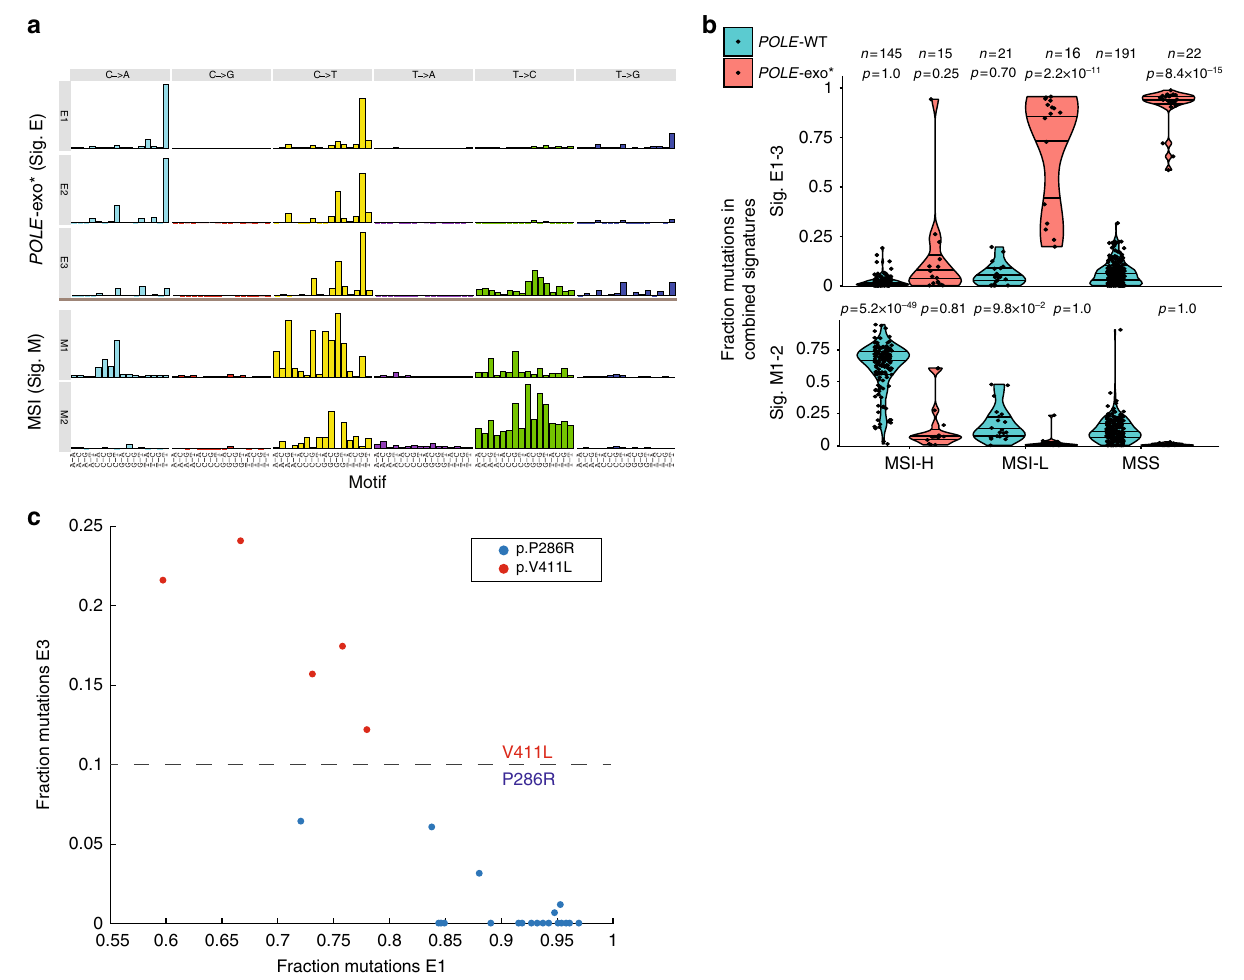
Fig. 2 Identi fi cation of mutational signatures associated with individual loss of POLE proofreading or MMR. a SignatureAnalyzer yielded fi ve mutational signatures associated with loss of polymerase proofreading (E1, E2, and E3) or mismatch repair (M1 and M2). For each mutational signature, the number of mutations is plotted for the 96 trinucleotide mutational contexts. b The fraction of mutations assigned to each signature across patients, segregated by POLE -exo mutations and Bethesda microsatellite classi fi cation. The distribution of each group is compared to that of polymerase wild-type MSS samples using a one-tailed rank-sum test. Horizontal lines within each group represent quartile values. c Relative contribution of E1 and E3 signatures to 5 V411L and 20 P286R samples with spectra dominated (>75% contributions) by signatures E1 – 3. Tumors with the P286R hotspot mutation have primarily contributions from E1, whereas tumors with a V411L hotspot mutation have additional contributions from